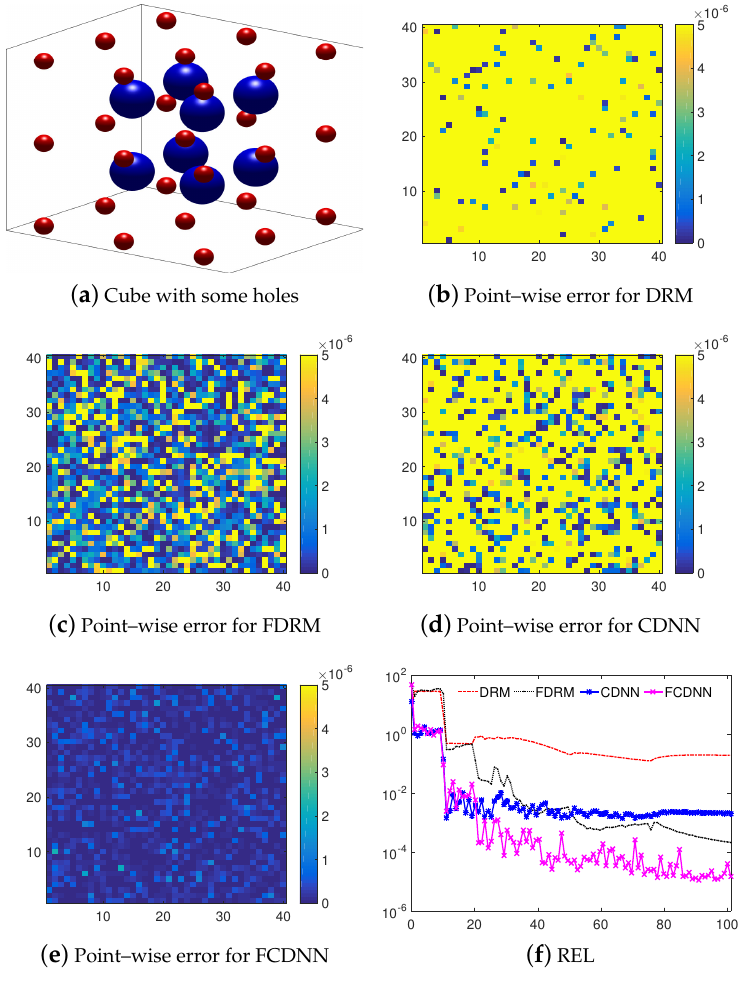
Figure 6. Testing results for Example